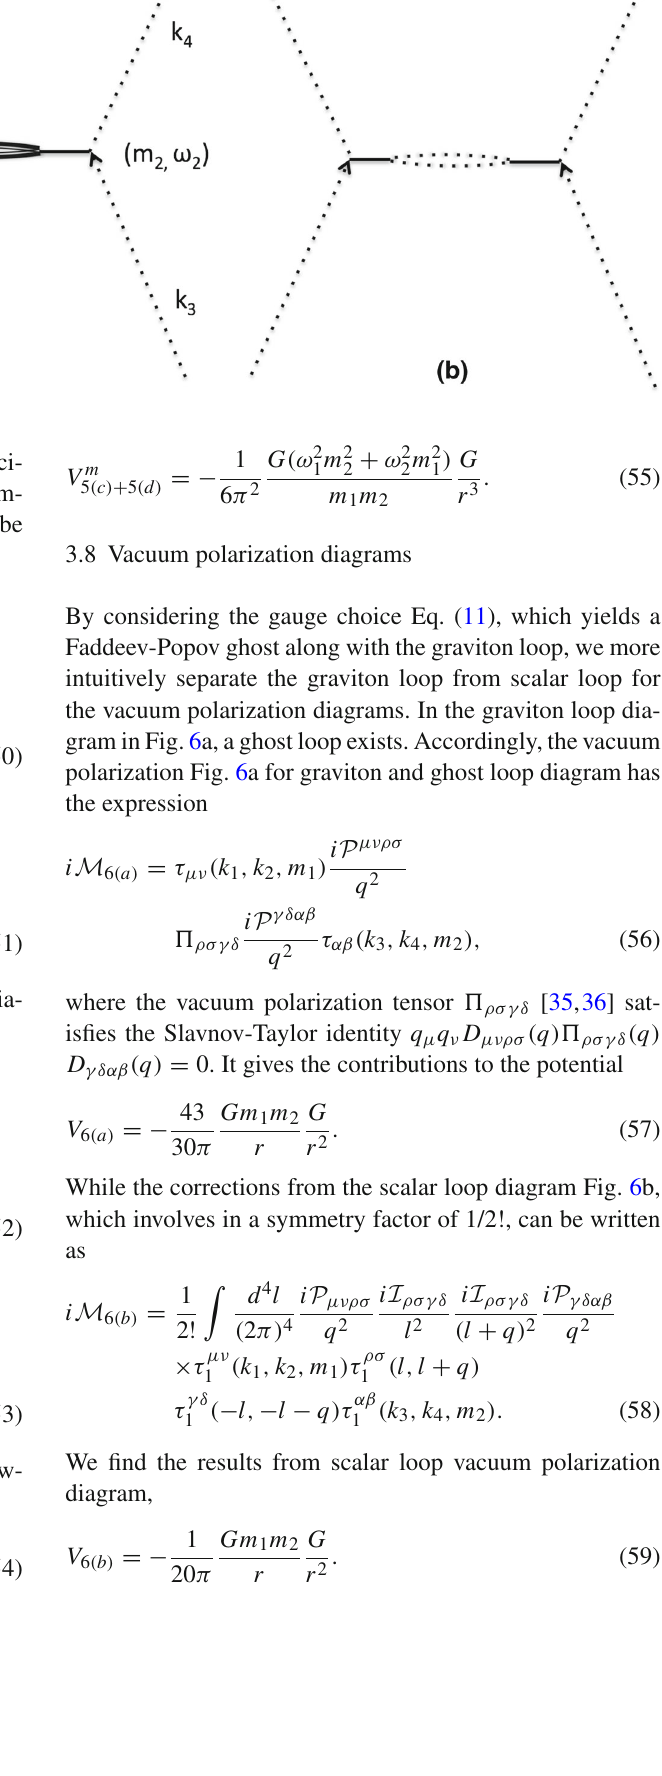
Fig. 6 The set of vacuum polarization diagrams contribute to the non-analytic corrections to the potential. The graviton loop diagram contains a ghost one, which is marked by the double line in ( a